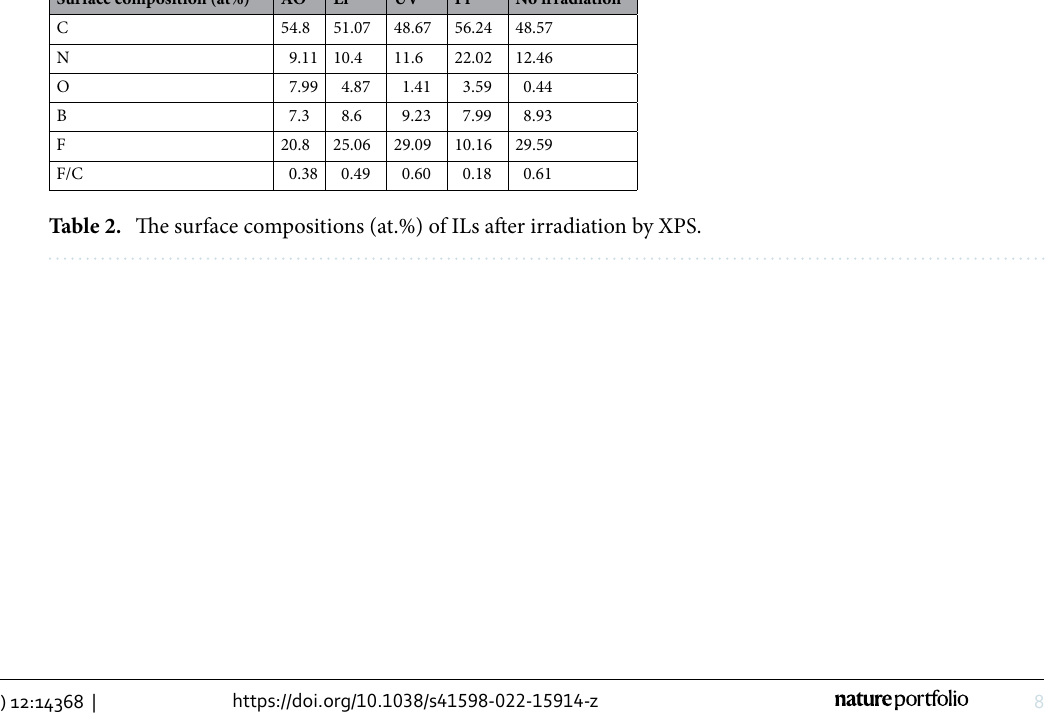
Surface composition (at%)